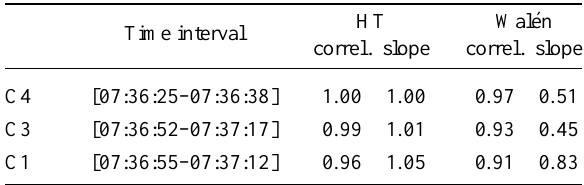
Table 6. Results from the Wal´en analysis performed on C4, C3 and C1 data. For each satellite we show the interval of analysis, the correlation coefficient and regression line slope provided by the HT analysis, and the correlation coefficient and regression line slope obtained in the actual Wal´en